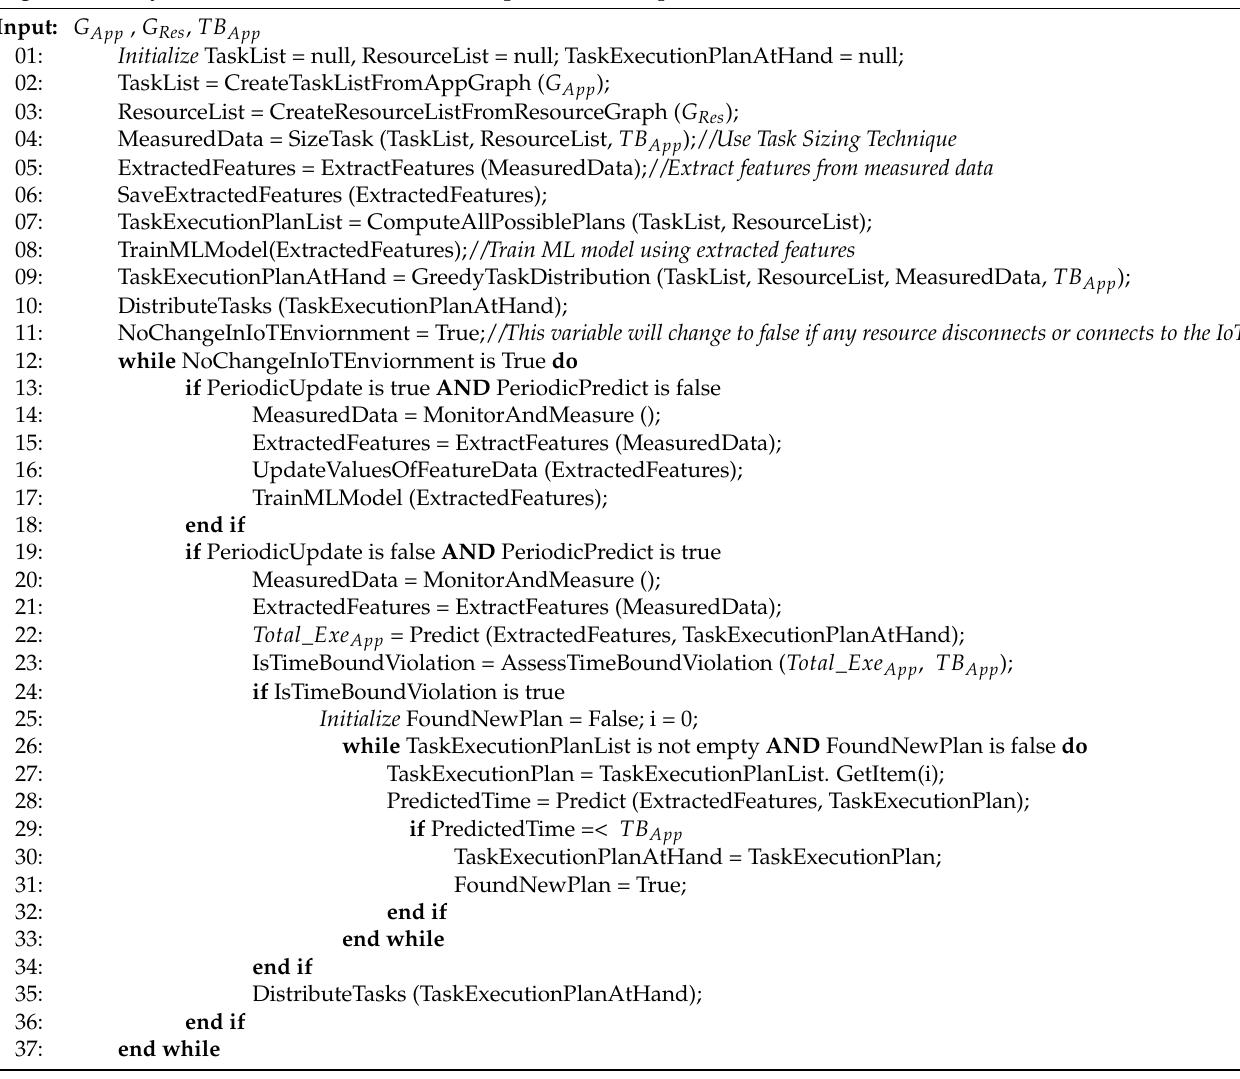
Algorithm 3: Dynamic Task Distribution and Adaptation Technique